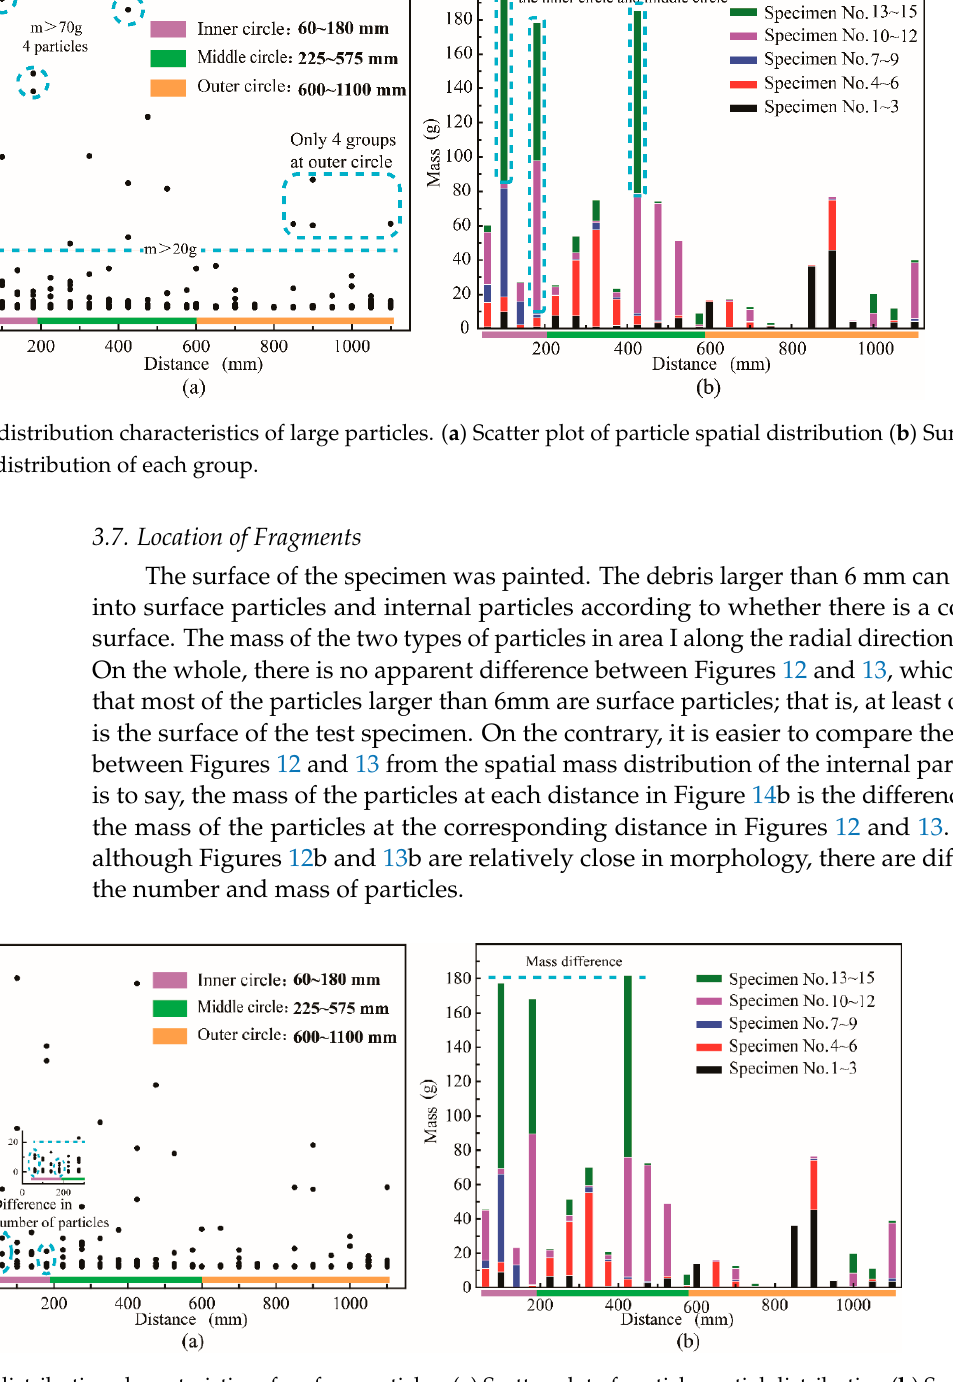
Figure 11. Spatial distribution characteristics of fine particles. ( a ) Scatter plot of particle spatial distribution ( b ) Summary of particle spatial distribution of each group.